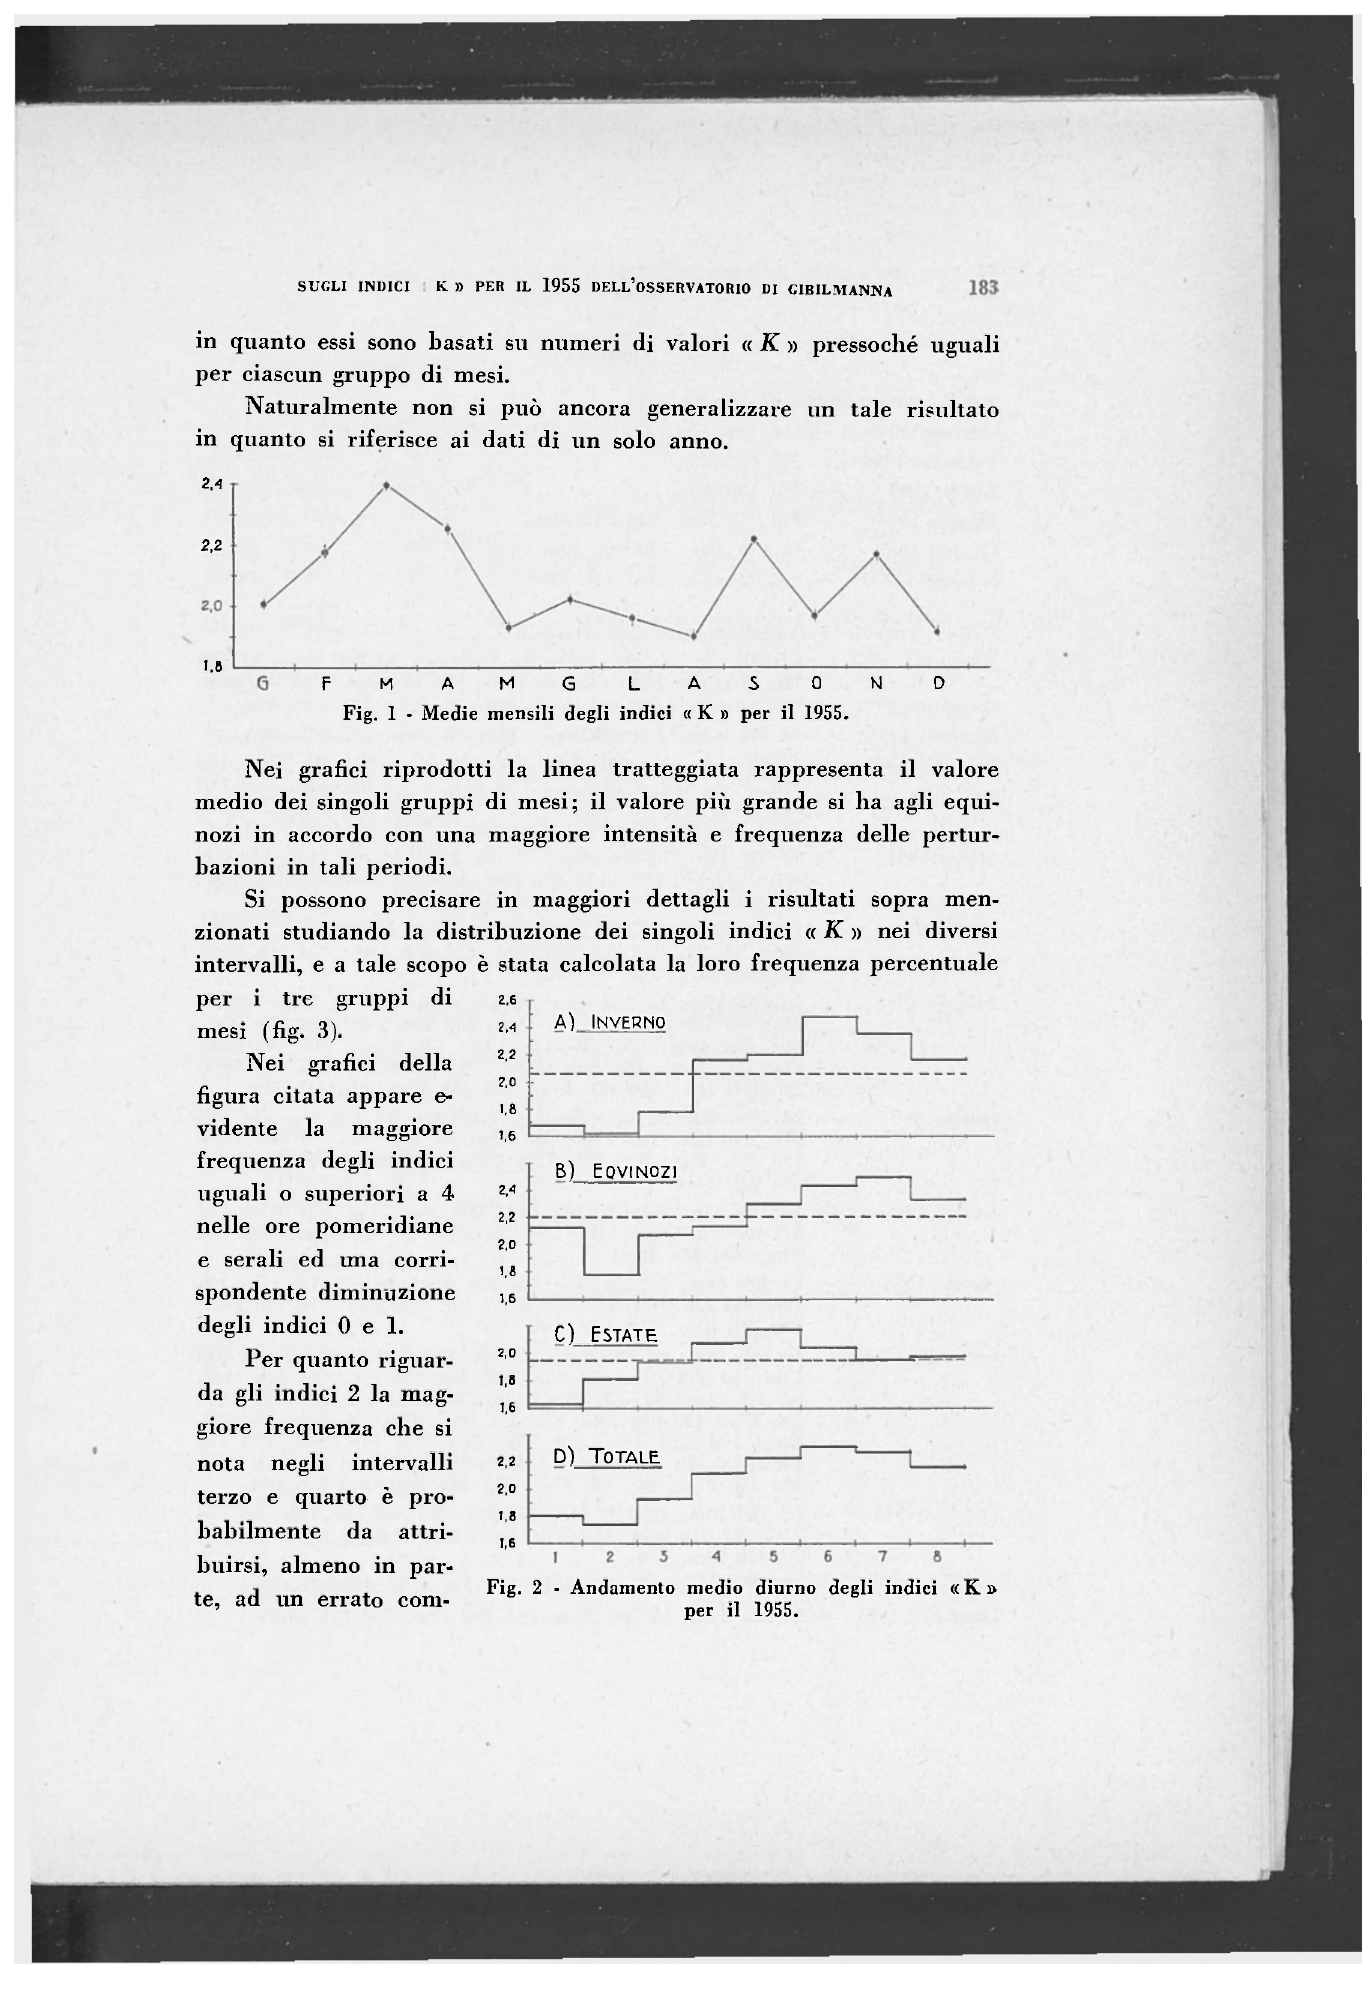
Fig. 2 - Andamento medio diurno degli indici « K » per il